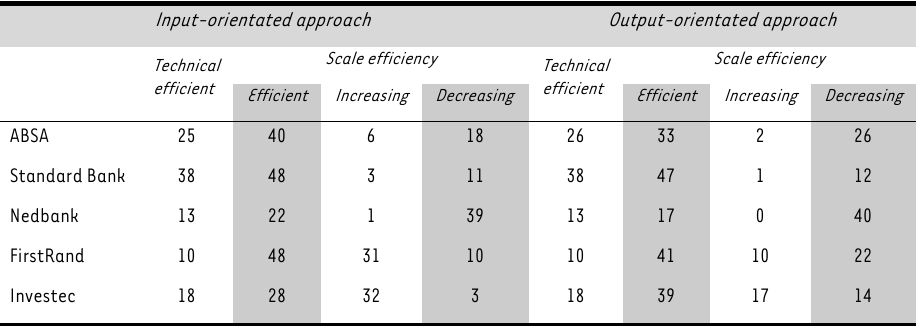
Summary of the average efficiency